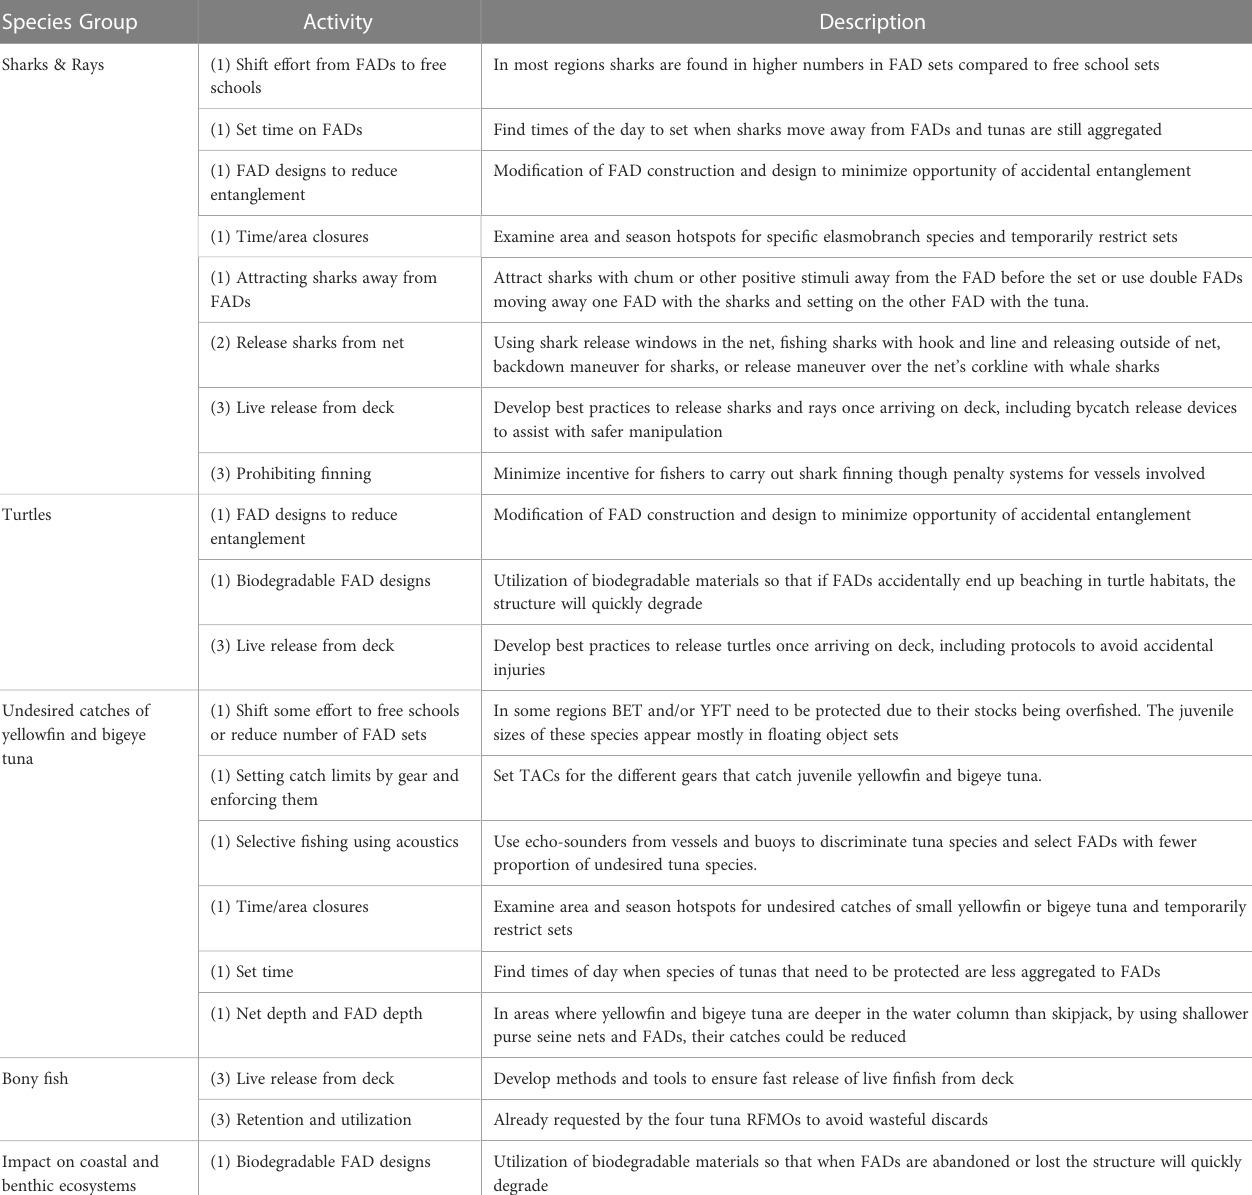
TABLE 2 ISSF Bycatch Project mitigation activities discussed between scientist and fi shers during the ISSF Skippers Workshops, by species groups and time in the fi shing operation (1) before, (2) during and (3) after the set. Species Group